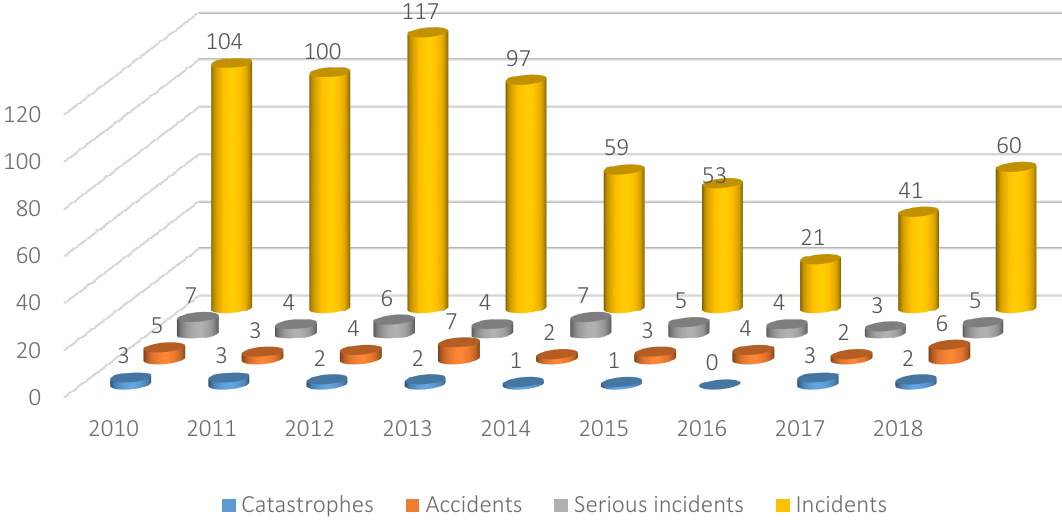
Figure 3. Dynamics of aviation cases in Ukraine during